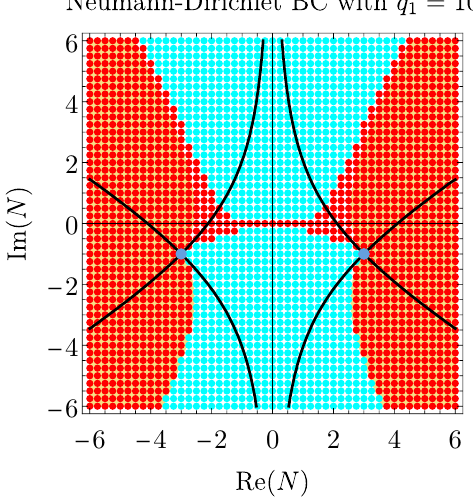
Figure 13 . A numerical plot of the allowed (cyan) and disallowed (red) metrics in the complexified lapse plane satisfying initial Neumann and final Dirichlet conditions, as appropriate for a momentum space definition of the no-boundary wave function. Here D = 4 , Λ = 3 , ˙ q | t =0 = +2 Ni , and q ( t = 1) = 10 . The shaded orange region is the disallowed region discussed and plotted in figure 12, though in 4 dimensions here. The saddle points (in blue) reside at the boundary of the allowable domain. The steepest ascent/descent lines (in black) emanating from the saddle points are seen to significantly impinge on the non-allowable region. Nevertheless, integration contours residing entirely in the lower half plane remain